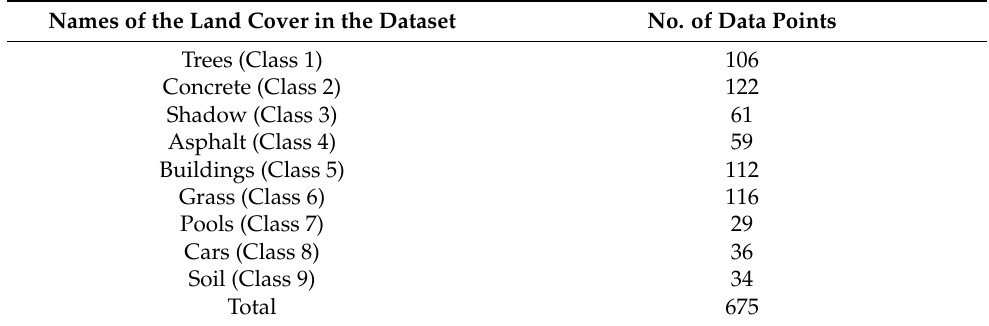
Table 10. Attribute information in the urban land cover dataset. Source of Information of the Names of Attributes in the Dataset Segments BrdIndx: border index Shape Area: area in m 2 Size Round: roundness Shape Bright: brightness Spectral Compact: compactness Shape ShpIndx: shape index Shape Mean_G: green Spectral Mean_R: red Spectral Mean_NIR: near Infrared Spectral SD_G: standard deviation of green Texture SD_R: standard deviation of red Texture SD_NIR: standard deviation of near infrared Texture Shape GLCM1: gray-level co-occurrence matrix Texture Rect: rectangularity Shape GLCM2: another gray-level co-occurrence matrix attribute Texture Dens: density Shape Assym: asymmetry Shape NDVI: normalized difference vegetation index Spectral BordLngth: border length Shape GLCM3: another gray-level co-occurrence matrix attribute Texture